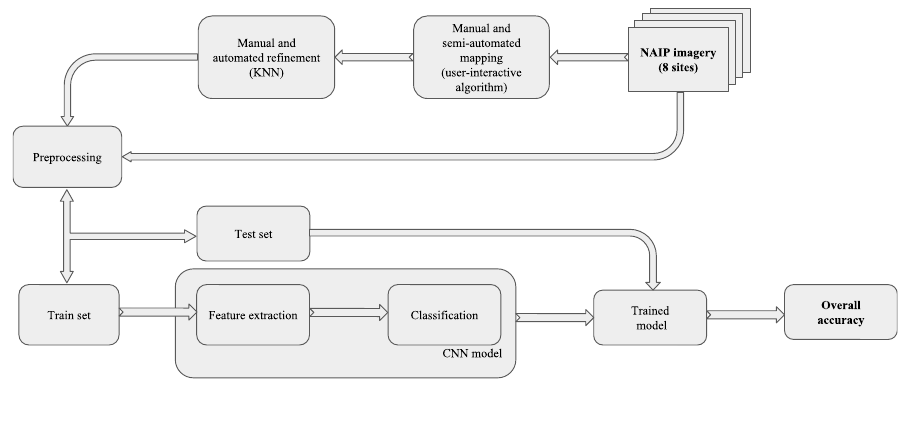
Figure 5. Workflow diagram for imagery classification and model